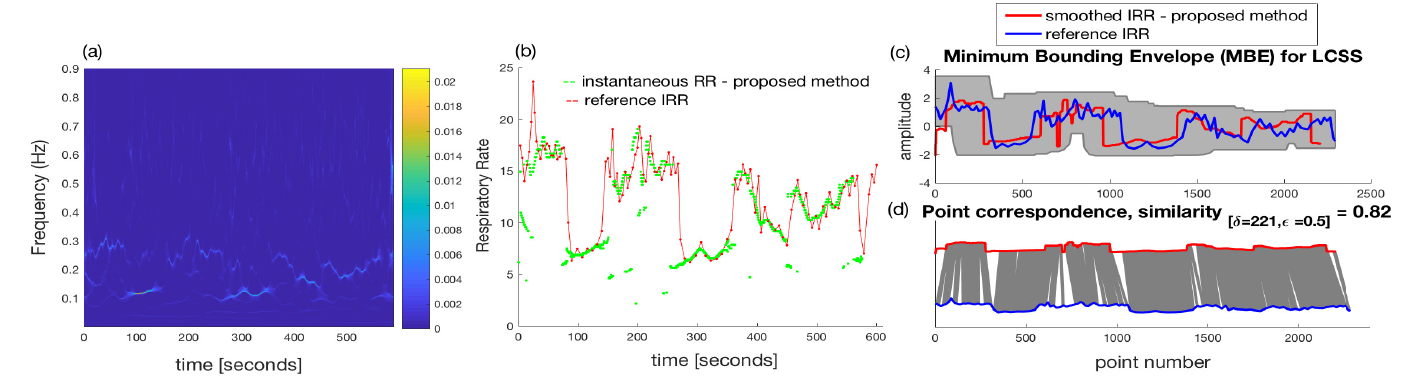
Figure 8. ( a ) The wavelet synchrnosqueezed transform of the derived and resampled FM for subject #1; ( b ) Estimated instantaneous respiratory rate using the proposed technique. The reference is shown in red color; ( c , d ) Similarity of estimated instantaneous respiratory rate and the reference using the longest common subsequence algorithm. A similarity of 0.82 (maximum similarity is 1) has been obtained for subject #1. The reference RR has been shown in blue color in ( c , d ).